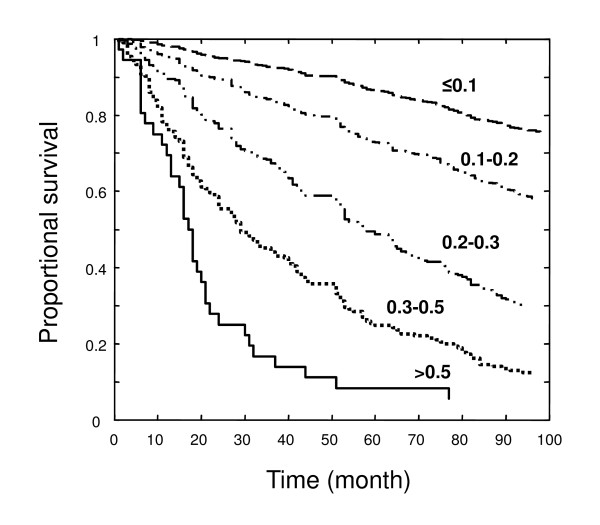
Kaplan Meier curves for the proportional survival of people with various levels of the FI. From top to bottom, FI ≤ 0.1 (n = 1510; dashed line), 0.1 < FI ≤ 0.2 (n = 937; dot-dashed line), 0.2 < FI ≤ 0.3 (n = 306; dot-dot-dashed line), 0.3 < FI ≤ 0.5 (n = 193; dotted line), FI > 0.5 (n = 36; solid line).